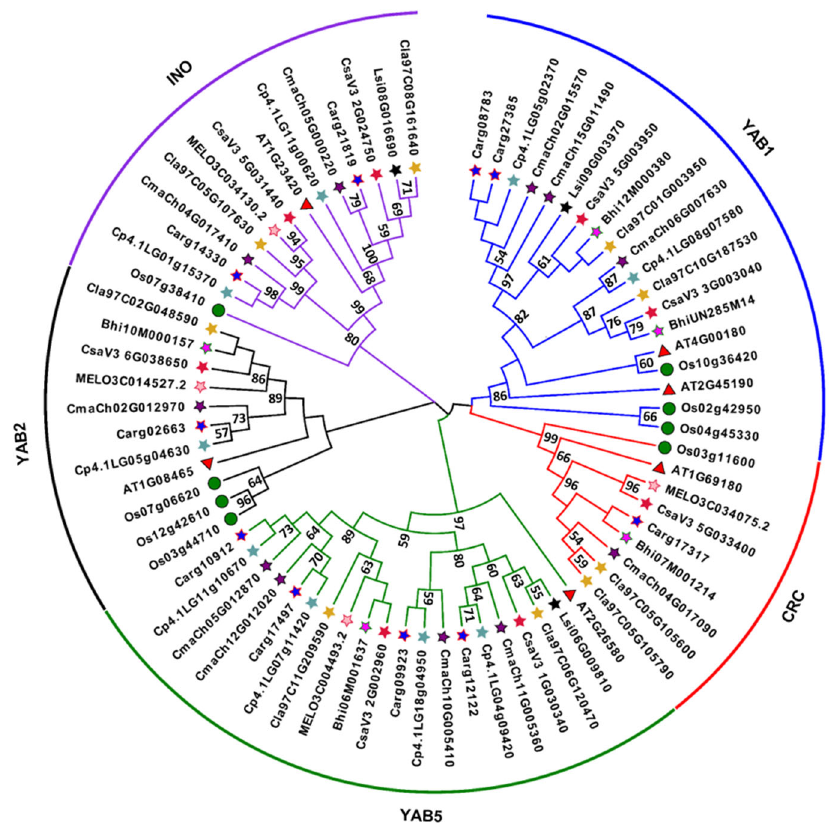
Figure 1. Phylogenetic tree of the YABBY proteins from Arabidopsis, rice, and eight cucurbit species. Red star, red star filled with pink color, yellow star, green star filled with light purple color, black star filled with dark purple color, bluish grey star, red star filled with blue color, black star, black triangle filled with red color and black circle filled with green color represent the YABBYs from cucumber, melon, watermelon, wax gourd, pumpkin, zucchini, silver-seed gourd, bottle gourd, Arabidopsis, and rice, respectively. Cs, cucumber ( C. sativus L.); MELO, melon ( C. melo L.); Cla, watermelon ( C. lanatus ); Bhi, wax gourd ( B. hispida ); Cma, pumpkin ( C. maxima ); Cp, zucchini ( C. pepo L.); Carg, silver-seed gourd ( C. argyrosperma ); Lsi, bottle gourd ( L. siceraria ); AT, Arabidopsis ( Arabidopsis thaliana ); Os, rice ( Oryza sativa L.).